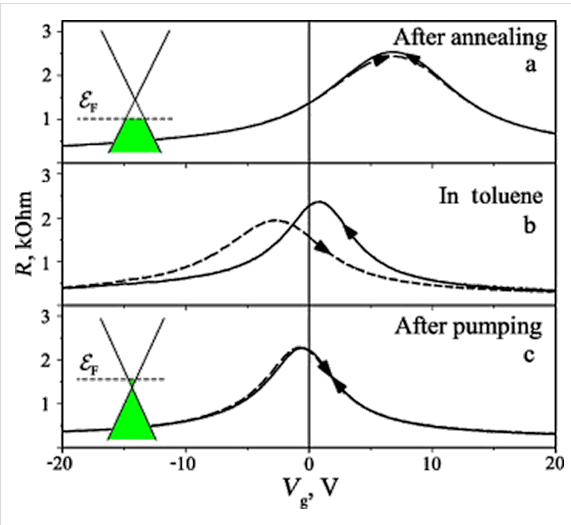
Figure 8: Resistance (kOhm) as a function of the gate voltage ( V g ) a) for pristine graphene after annealing in vacuum, b) after exposure to toluene and c) and pumping out the toluene vapour. The shift of the resistance peak towards negative ( V g ) after the exposure of toluene indicates that the molecule acts as a n-type dopant. Pumping out the toluene from the chamber removes the hysteresis but the doping effect remains. Reprinted with permission from [24]. Copyright 2011